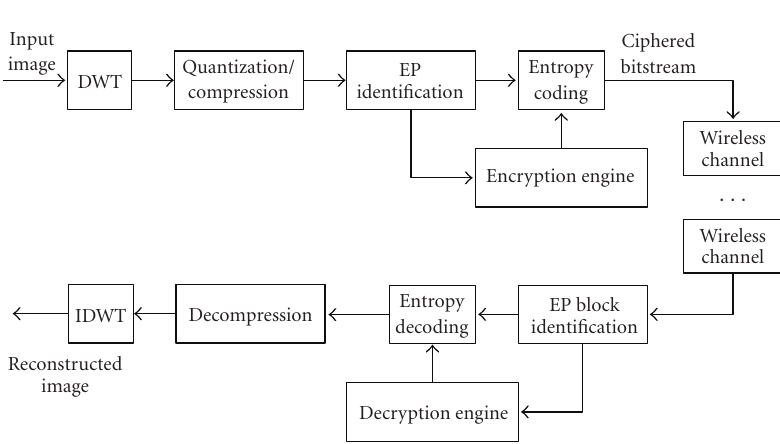
Figure 1: Selective encryption data flow for embedded